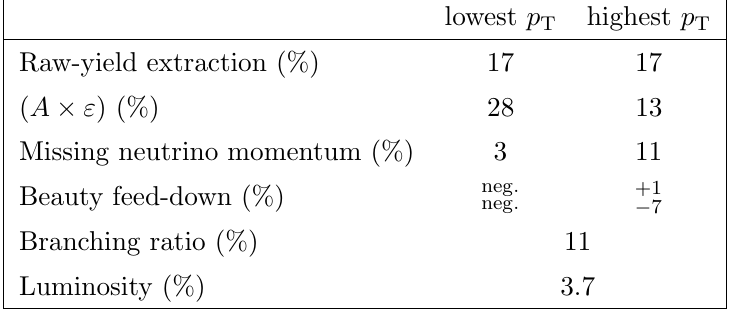
! e + (cid:23) e (cid:3) analysis in pp collisions. c